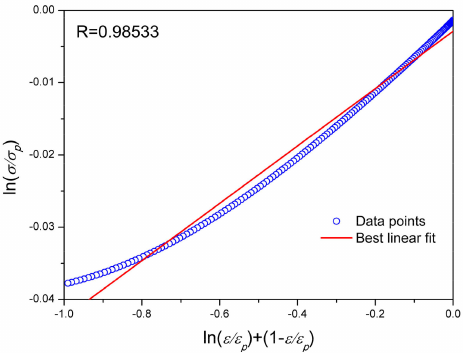
Figure 6. Relation between ln( σ / σ p ) and [ln( ε / ε p ) + (1 − ε / ε p )] in the post-peak stage.